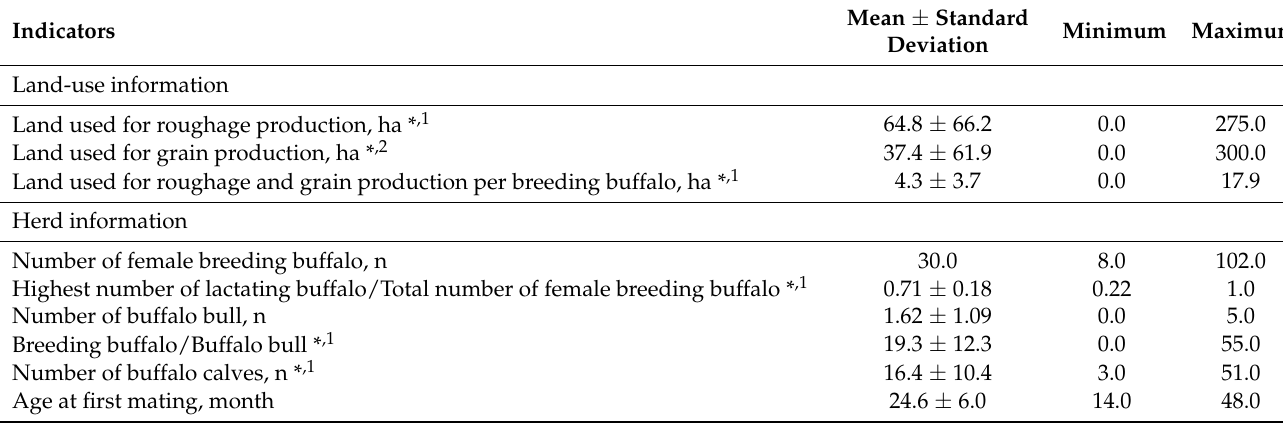
Table 1. Structural and management characteristics of the buffalo farms in Marmara region (mean ± standard deviation, minimum,